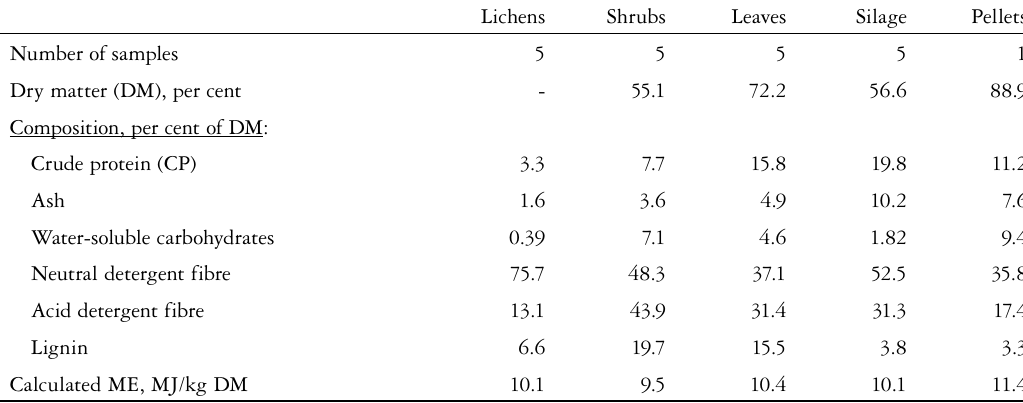
Table 1. Chemical composition and calculated metabolisable energy (ME) of various feedstuffs (from Nilsson et al., 2000).